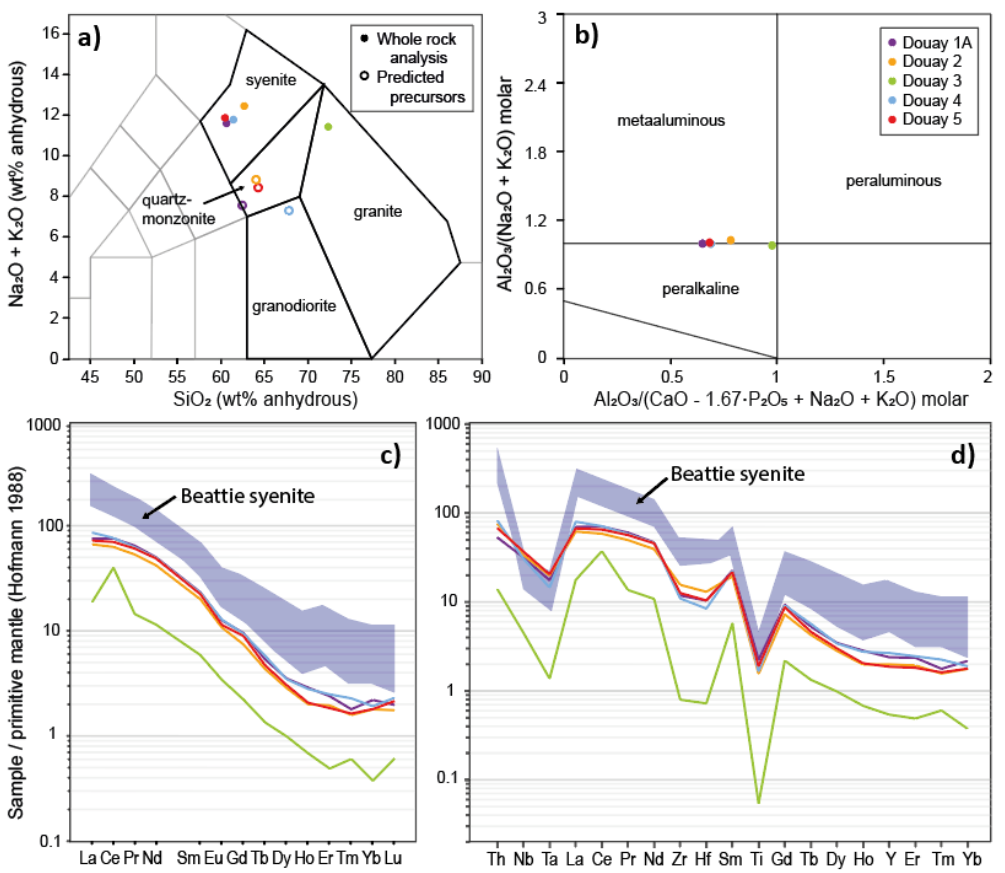
Figure 4. Chemical composition of five rock samples from the Douay intrusive complex. Rocks are displayed on ( a ) the Total Alkali Silicate (TAS) binary diagram and on the ( b ) Al saturation index (ASI) vs. Al/NK binary diagram [41]. Rocks are also displayed on ( c ) a primitive mantle-normalized [42] REE plot and ( d ) a primitive mantle-normalized multi-element arachnid diagram modified from Pearce [43]. The chemical composition of the Beattie syenite (n = 32) is compiled from the literature [27–29].